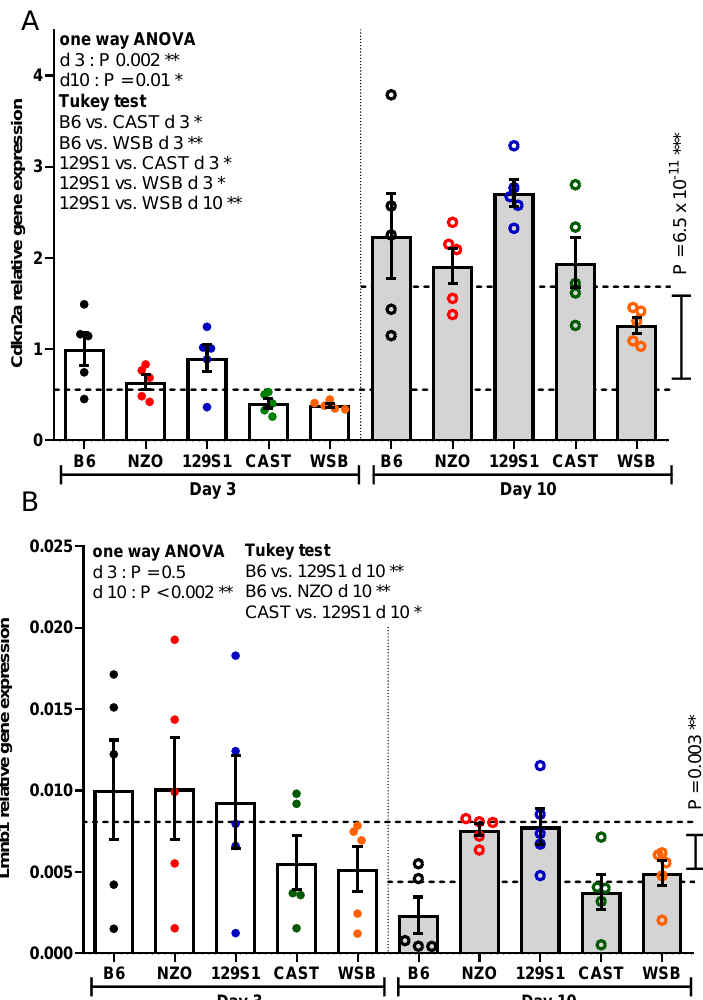
Figure 3. Analysis of cellular senescence using Cdkn2a and Lmnb1 transcriptional expression. ( A ) Cdkn2a expression and ( B ) Lmnb1 expression at days 3 and 10 after irradiation. Results are presented as means ± SEM ( n = 5 mice for each strain). Significance between means of strains and means of time points were tested by the one-way ANOVA and t -test, respectively. Tukey’s test was performed as a post-hoc analysis in the case of multiple comparisons. Results from days 3 and 10 are tested separately. * p < 0.05; ** p < 0.01; *** p < 0.001.